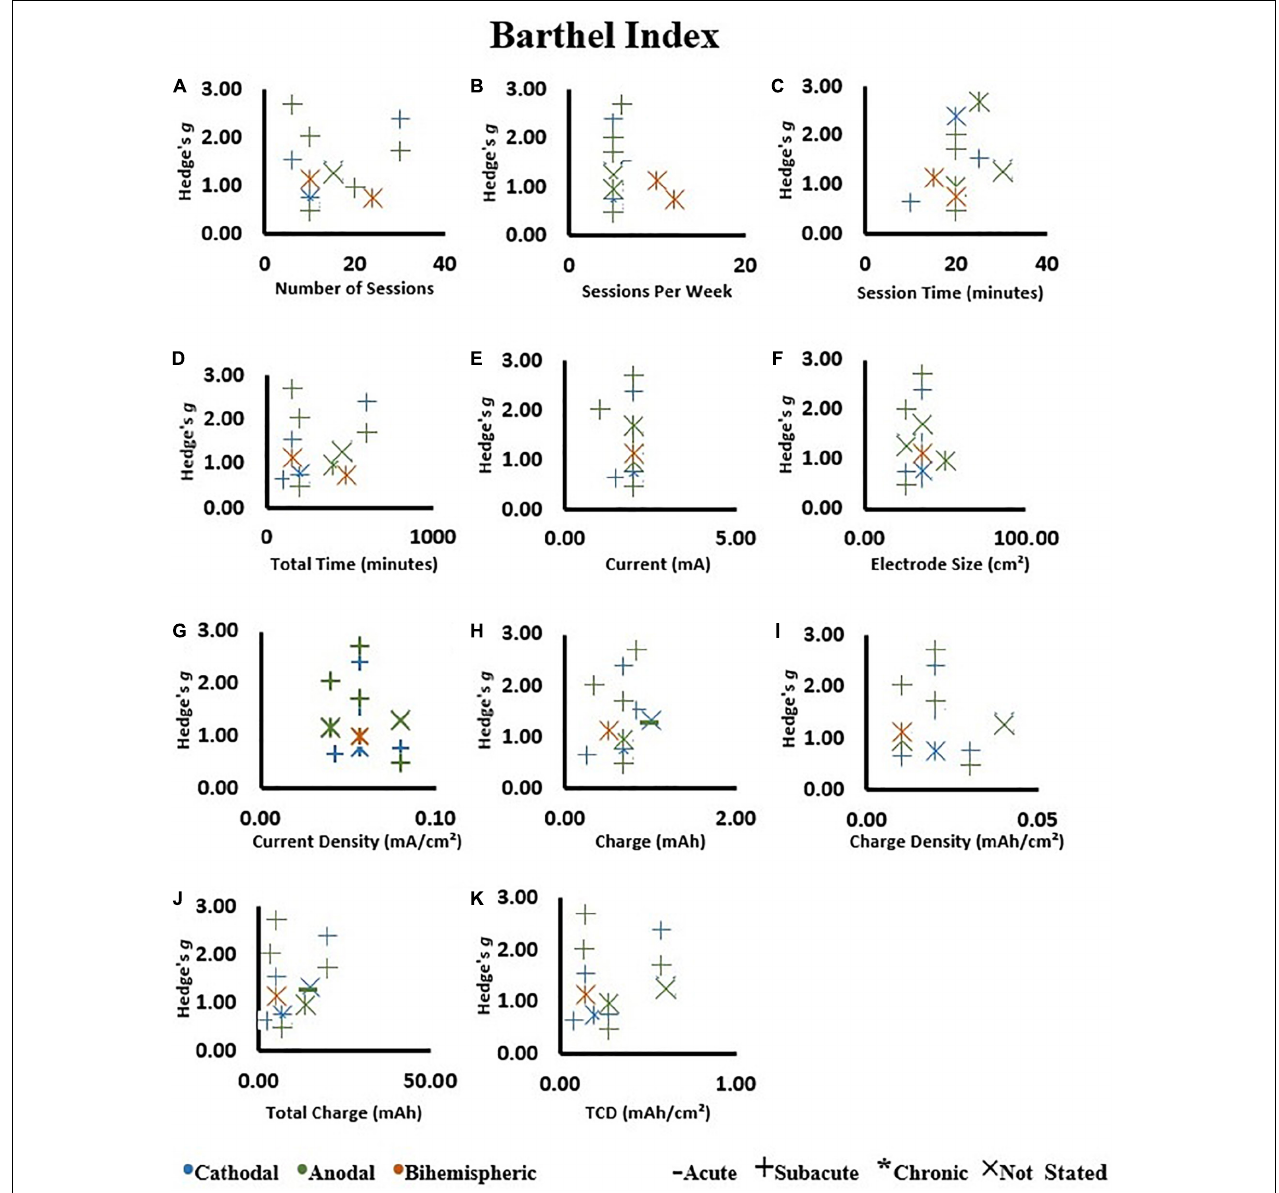
FIGURE 7 | Correlations on change scores in the tDCS groups as assessed by the Barthel Index. (A) Number of sessions, (B) sessions per week, (C) session time, (D) total tDCS application time, (E) current, (F) electrode size, (G) current density, (H) charge, (I) charge density, (J) total charge, and (K) total charge density (TCD). An increase in Hedge’s g effect size indicates a better